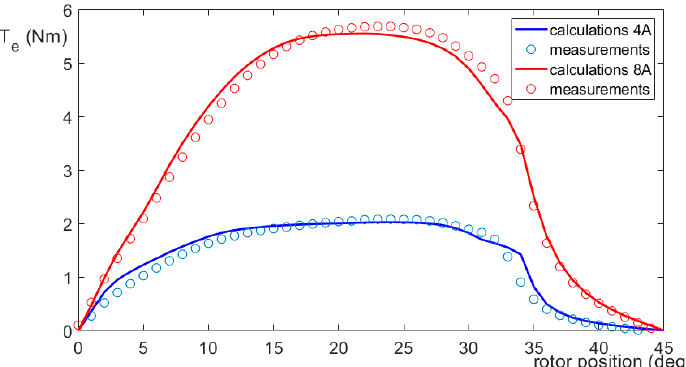
Figure 1. Calculated and measured characteristics of electromagnetic torque T e .